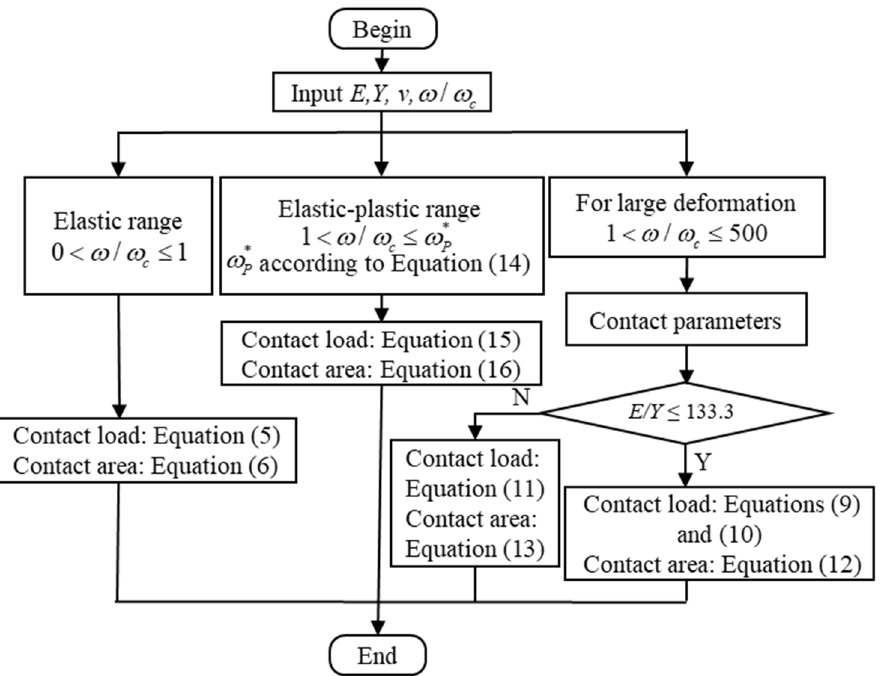
Figure 13. Flowchart for predicting the contact parameters.